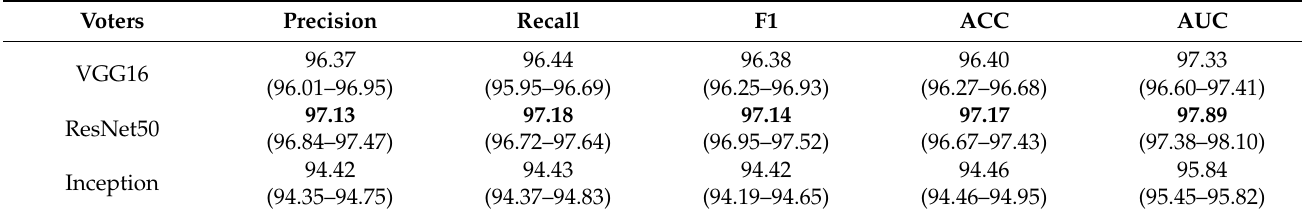
Table 2. Performance (in %) of voters on unseen data.